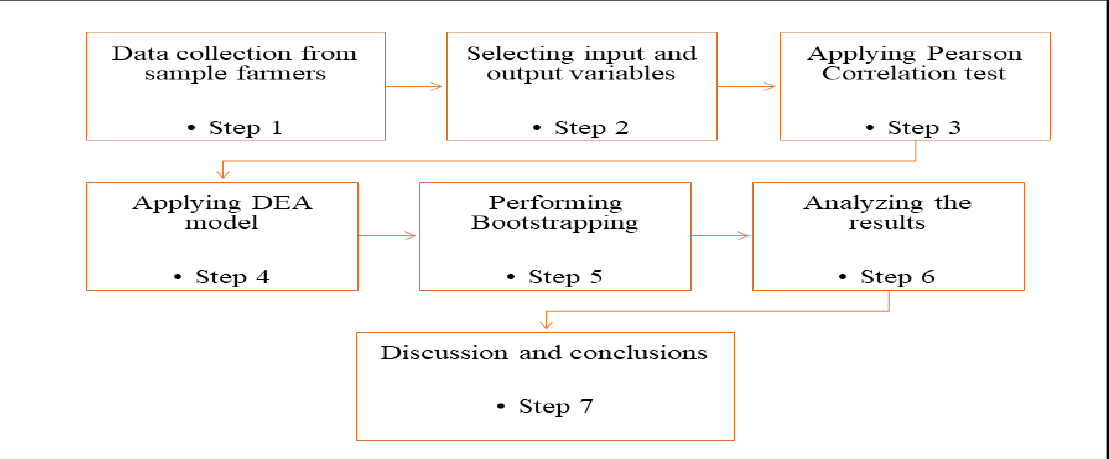
Figure 1. Steps to follow in DEA analysis.